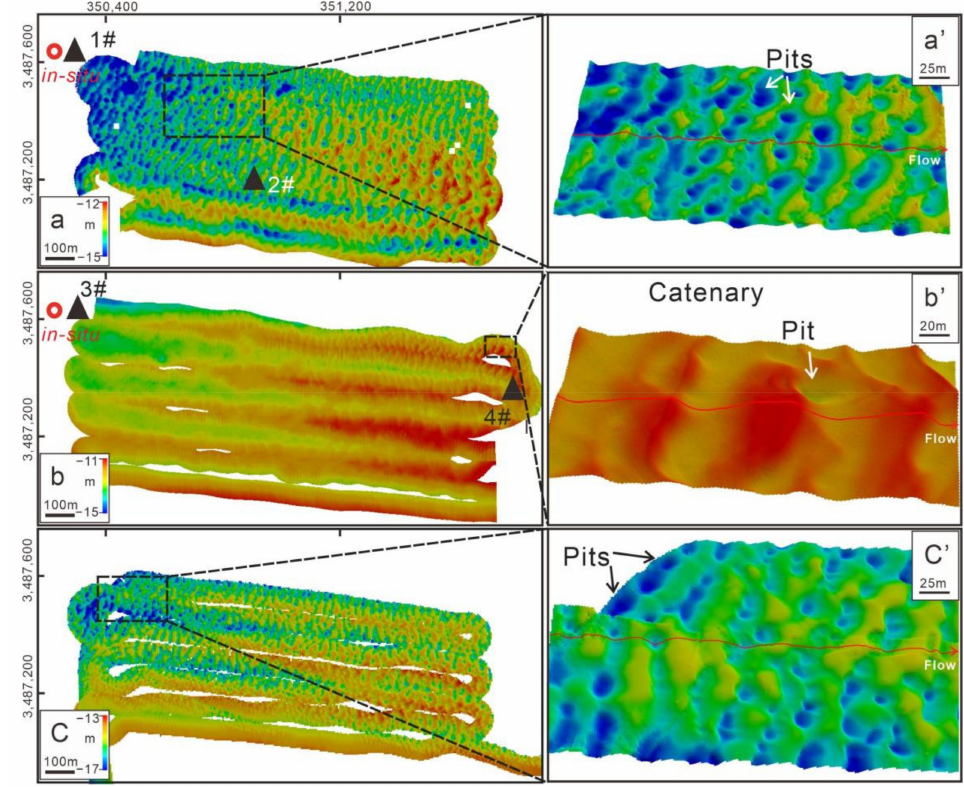
Figure 3. Bedforms in the South and North Channel of the YR Estuary. ( a ) October 2014 (adapted from Zheng et al., 2016 [20]); ( b ) February 2015; and ( c ) July 2015. Panels ( a’ – c’ ) show enlarged views of the areas in the white rectangles. Red circles in Figure 3a,b are locations of flow data collection. Black triangles in Figure 3a,b are locations of sediment